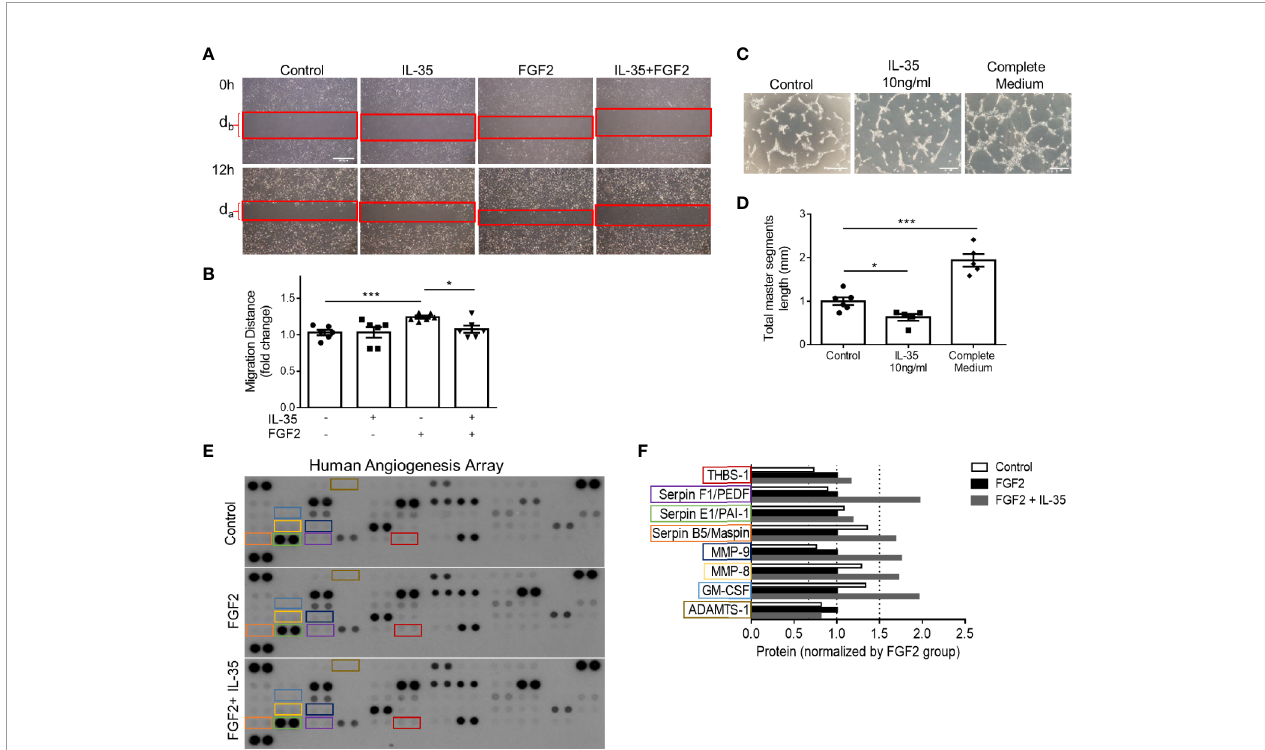
FIGURE 7 | IL-35 inhibits human microvascular endothelial cell (HMVEC) migration and tube formation in vitro mainly through upregulating anti-angiogenic extracellular matrix-remodeling proteins. (A, B) Representative images and statistics of wound healing assay. Scale bar is 500 µm Migration distance (mm) = (d b